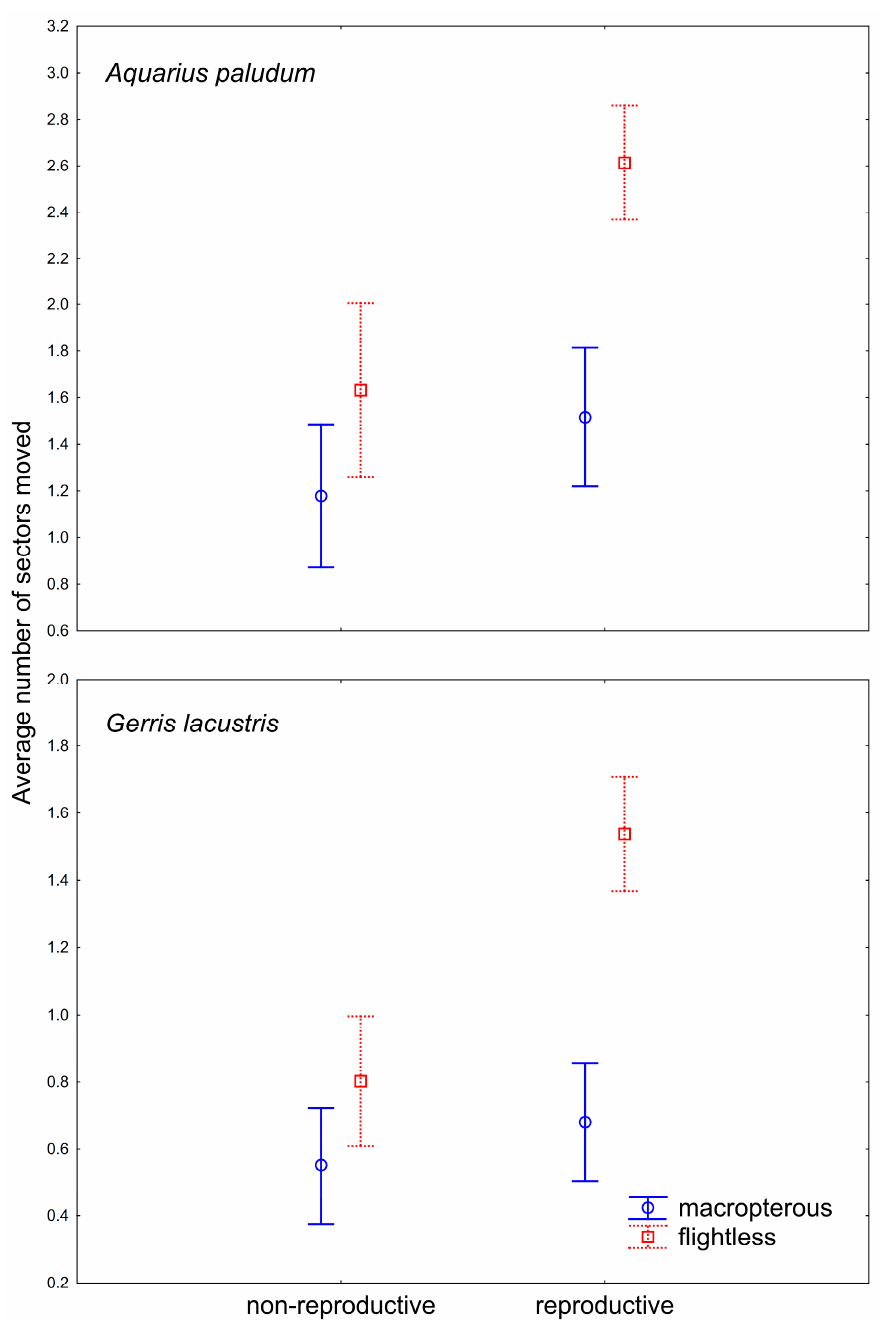
Figure 4. The difference in within-site movement in wing-dimorphic reproductive and non- reproductive females of A. paludum and G. lacustris. Vertical bars denote 0.95 confidence intervals. Table 3. Statistical significance of effect of reproductive state, wing morph and their interaction on intra-pond movement score in females of A. paludum and G. lacustris . Data pooled from all seasons and both fishponds. * = p < 0.05; ** = p < 0.01; *** = p < 0.001. Species Reproductive State (RS) Wing Morph RS × Wing Morph Species A. paludum *** G. lacustris